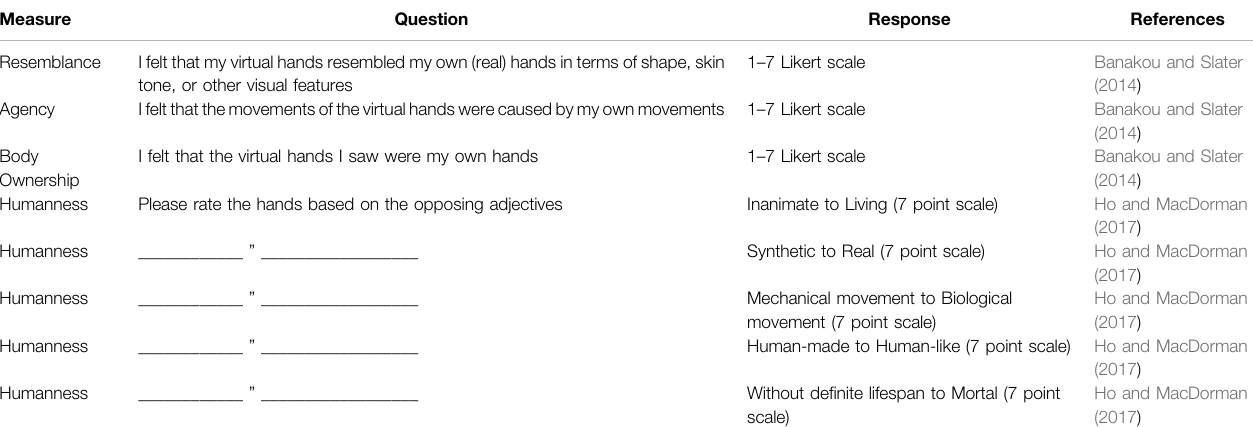
TABLE 1 | Measures used during validation.